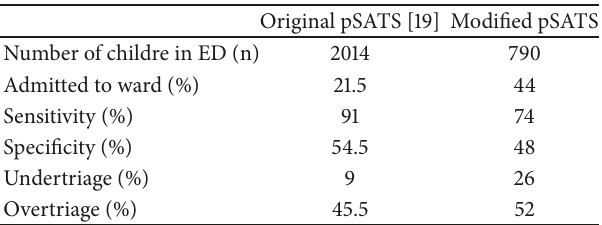
Table 5: Comparisonof data from the study on the original pSATS [19] and the modified